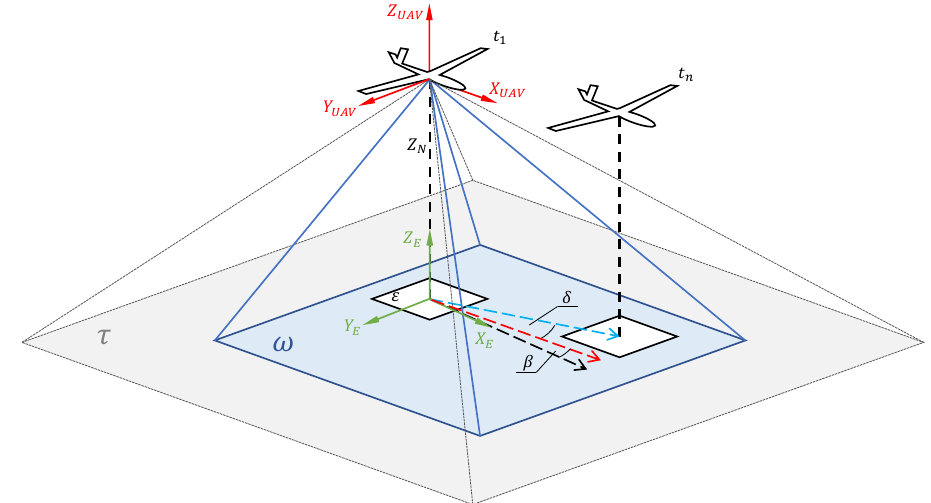
Figure 3. Coordinate system with template matching